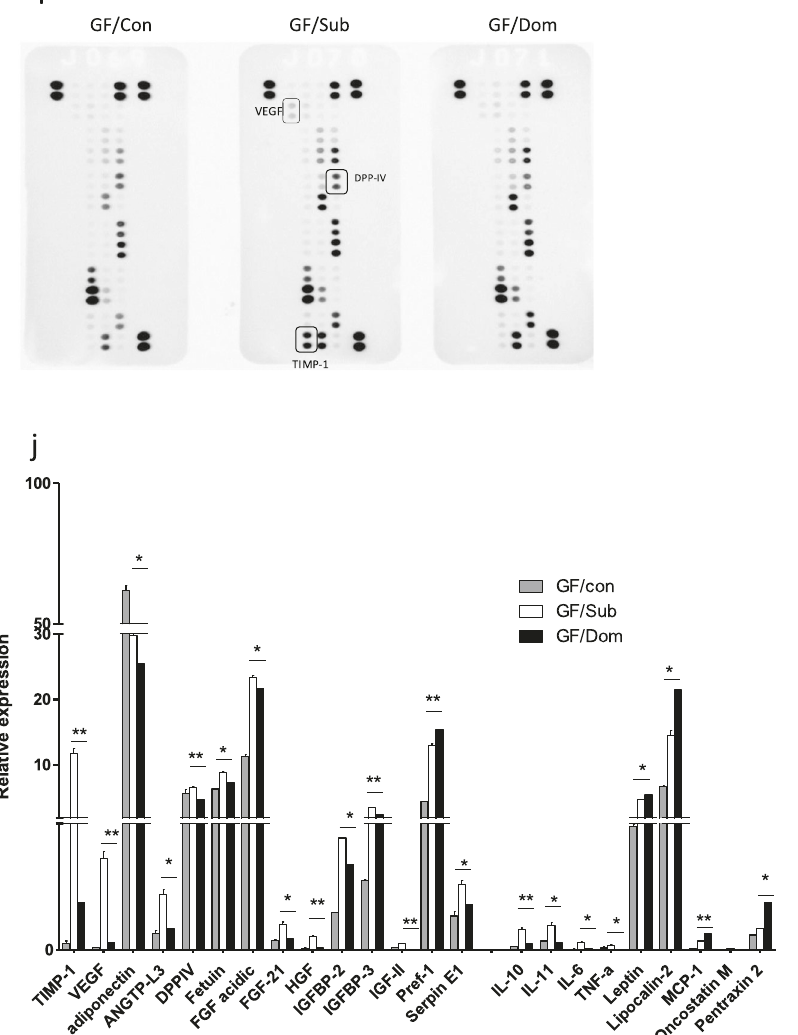
Fig. 6 The effects of FMT on mouse body weight, behavior, eWAT content, and adipokine pro fi le. a Body weight follow-up of transplanted GF mice. The curves represent the average mouse weight gain as a percentage from their weight at the day of transplantation. b – d Mouse social behavior, measured in the TCST. c , d The average velocity ( c ) and distance ( d ) per group shows similar locomotor activity in all the groups. e Depressive-like behavior, re fl ected in immobility time in the FST, in GF/Sub mice, as compared with normal behavior in GF/Dom mice. f Quanti fi cation of eWAT mass, obtained from GF mice, normalized to the respective body weight of each mouse. g Histological (H&E) staining of eWAT from GF-transplanted mice (×40 magni fi cation, scale bar = 20 μ m). h The eWAT cell diameter of transplanted GF mice was determined using the ImageJ software. Ten random cells per fi eld were analyzed from 10 random fi elds in each mouse. i An adipokine array comparison of pooled proteins extracted from the eWAT of GF/Sub ( n = 4) and GF/Dom ( n = 4). j The eWAT adipokines that their expression was signi fi cantly altered following FMT. Each bar represents the average of duplicate adipokine expression normalized to the positive control. GF/Sub mice demonstrated a signi fi cantly higher adipokine level than GF/Dom mice. Statistical signi fi cance was determined using Student ’ s t test or one-/two-way ANOVA with Bonferroni correction, * p < 0.05, ** p < 0.01. Error bars show standard